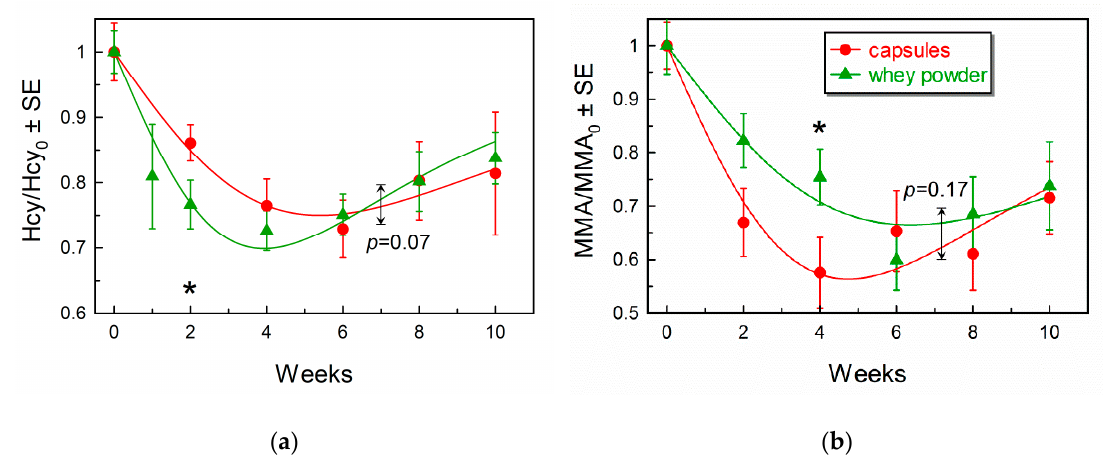
Figure 3. Time-dependent changes in the metabolites ( a ) Hcy and ( b ) MMA both expressed as fractions of the respective baselines (week 0) and fitted by Equation (2). Other annotations and descriptions are as in the legend to Figure 2.